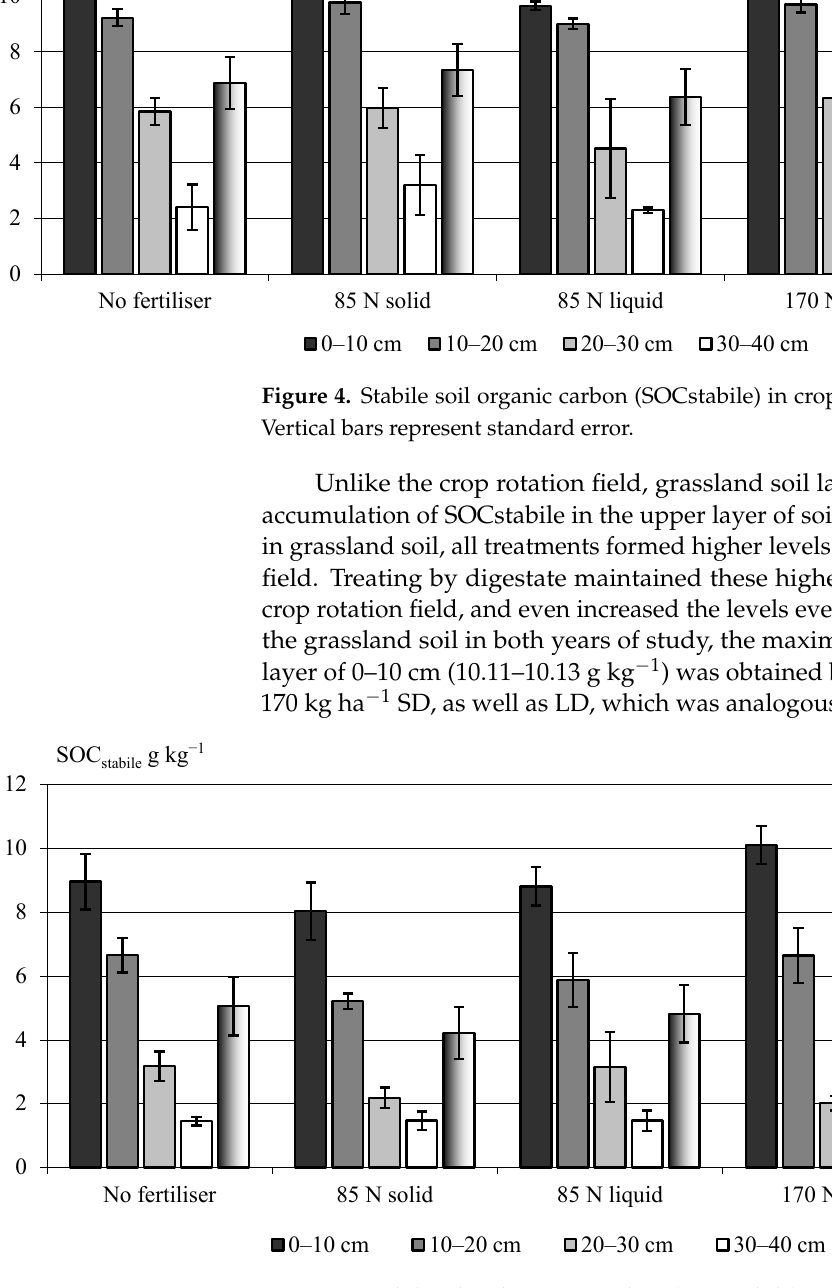
Figure 5. Stabilized soil organic carbon (SOCstabile) in grassland soil treated by digestate, 2020. Vertical bars represent standard error.